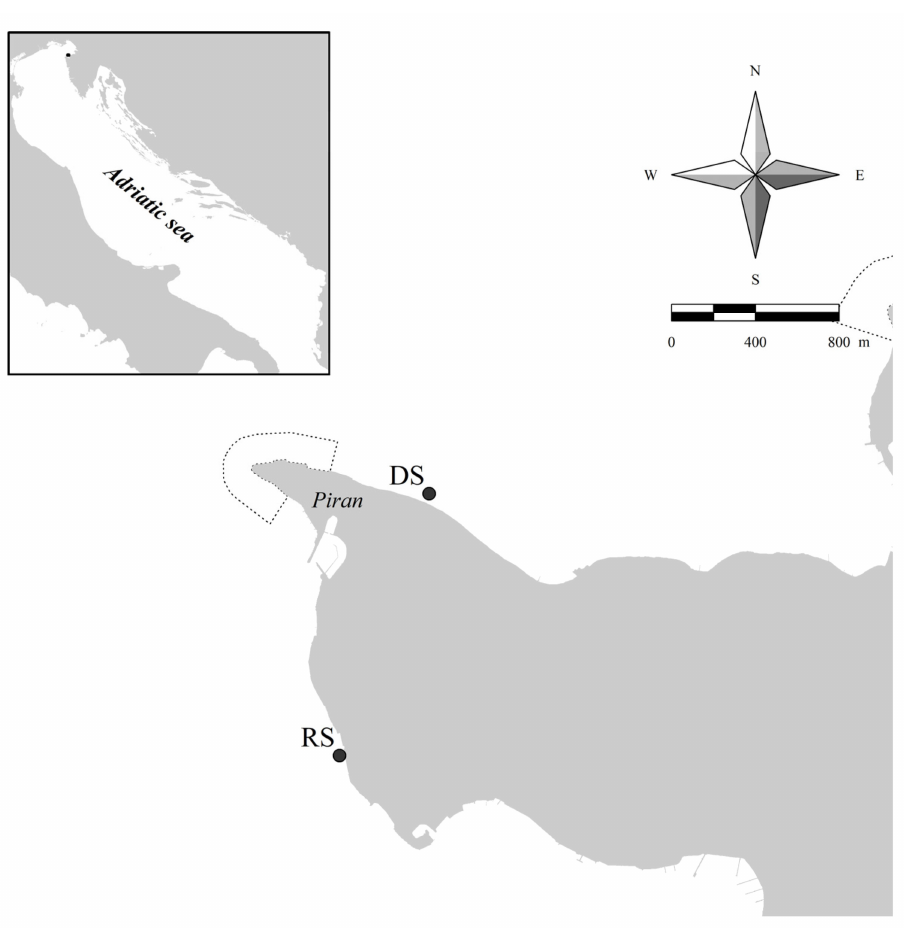
Figure 1. Study area in the Gulf of Trieste. DS—donor site of fertile apices of Gongolaria barbata , and RS—receiving site of ex situ cultivated recruits on clay tiles, in front of the Marine Biology Station Piran